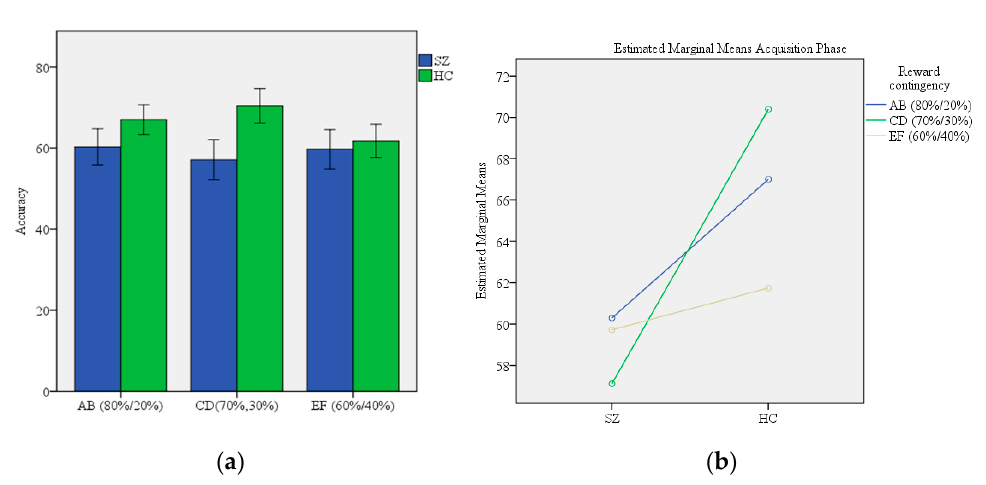
Figure 1. The comparison of performance on PST ( a ) Acquisition of probabilistic contingencies during training phase of PST for AB, CD and EF conditions in SZ patients and HC participants.; ( b ) Effects of group and reward contingency on acquisition accuracy of probabilistic contingencies during PST for AB, CD and EF conditions in SZ patients and HC participants. Abbreviations: PST—Probabilistic Selection Task, group: healthy control (HC), schizophrenia (SZ), reward contingency: AB (80%/20%), CD (70%, 30%), EF (80%, 20%). Table 2. Acquisition of probabilistic contingencies for AB, CD, and EF conditions. Models